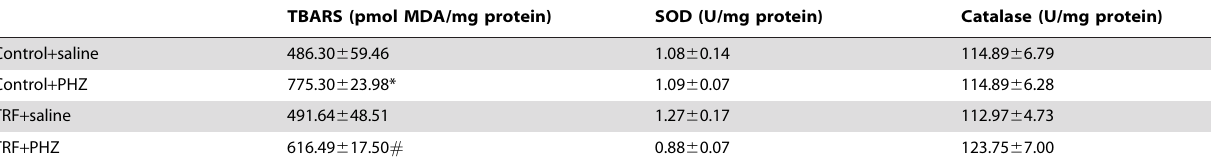
Table 2. Oxidative stress markers in liver.